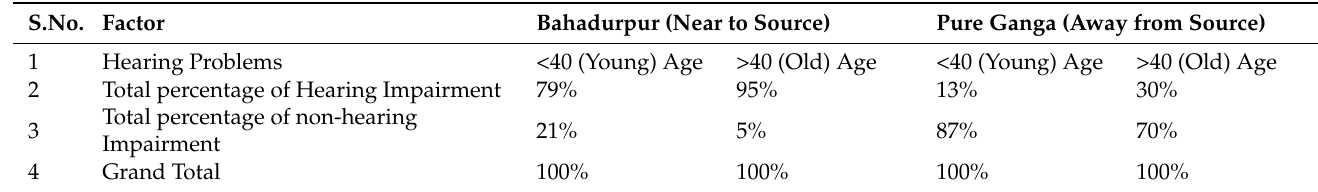
Table 3. Comparison of Health hazards of Bahadurpur and Pure ganga areas obtained through Audiometric Test.